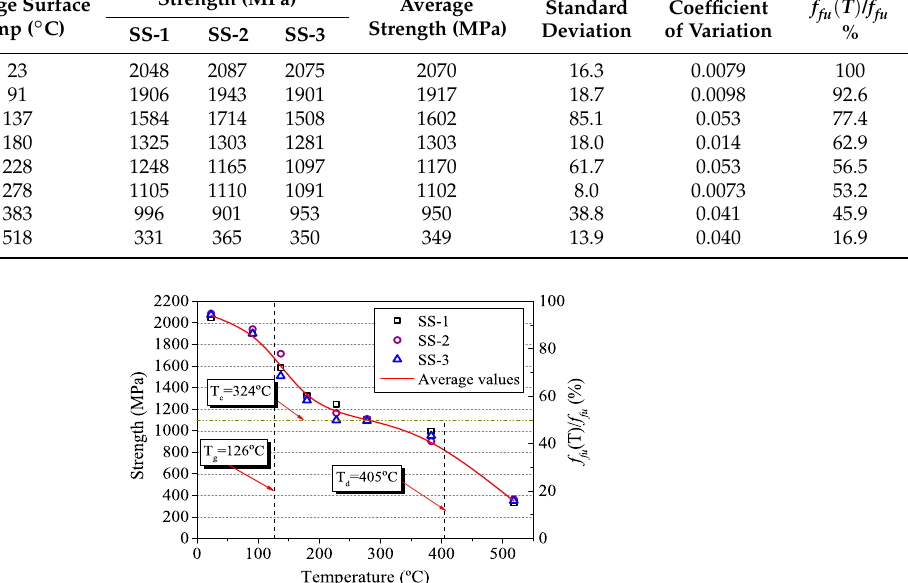
Table 3. Tensile strength of CFRP tendons in steady state tests.